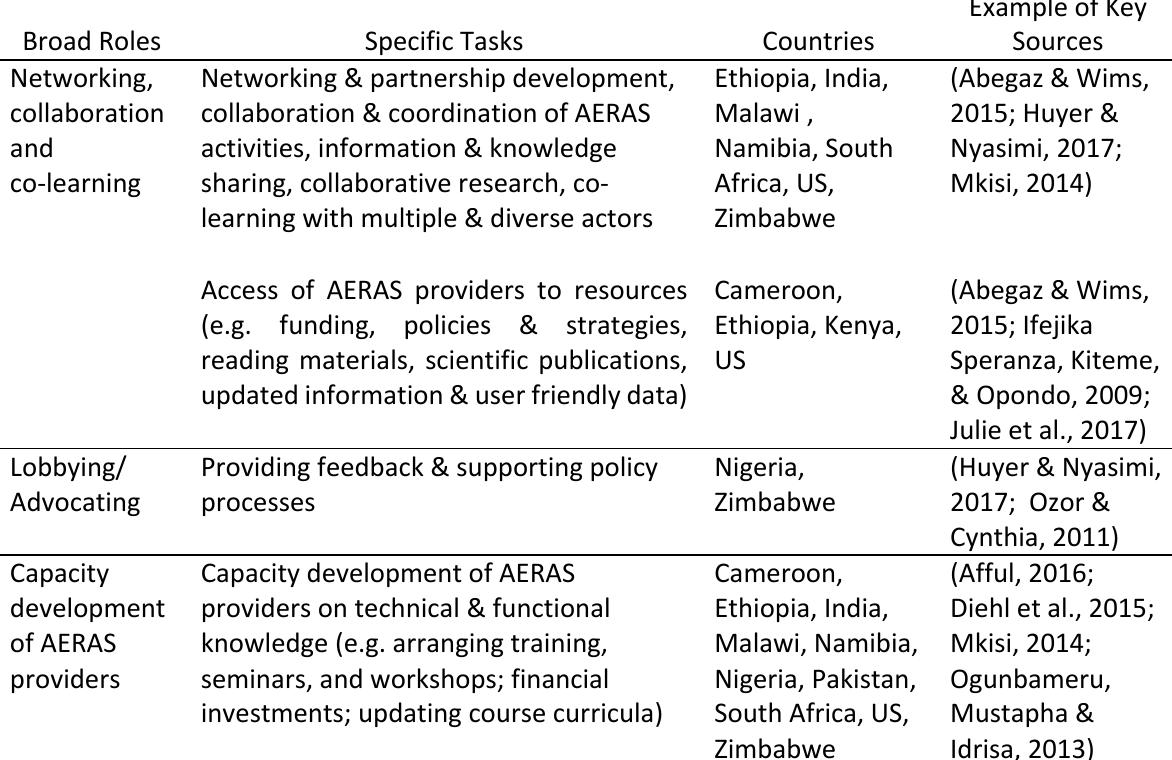
The Roles of AERAS Providers to Enhance Agricultural Innovation to Adapt to Climate Change: Insights from Empirical Studies in Different Countries Broad